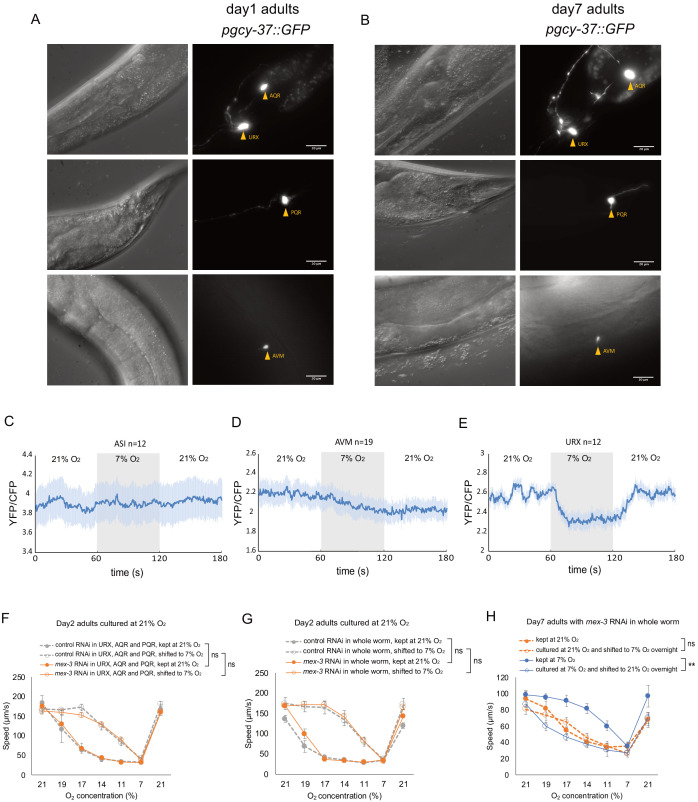
Structural and functional validation of the strain for cell-specific RNA-sequencing.(A–B) O2-sensing neurons (URX, AQR and PQR) and a touch receptor neuron AVM with GFP expression in day 1 (A) and day 7 (B) adults. Neurons are intact in both day 1 and day 7 adults. Scale bar = 20 µm. (C–E) In vivo functional Ca2+ imaging for ASI (C), AVM (D), and URX (E) in response to O2 levels. AVM and ASI do not show response to 21% O2. Mean ±sem. (F) Cell-specific RNAi knockdown of mex-3 does not affect O2-evoked behavior and its plasticity. Mean ±sem, n = 3 assays. (G) mex-3 RNAi feeding for the whole worm does not affect O2-evoked behavior and its plasticity in day 2 adults. Mean ±sem, n = 3 assays. (H) mex-3 RNAi feeding for the whole worm does not affect activity-dependent decline of plasticity with age. Mean ±sem, n = 3 assays.